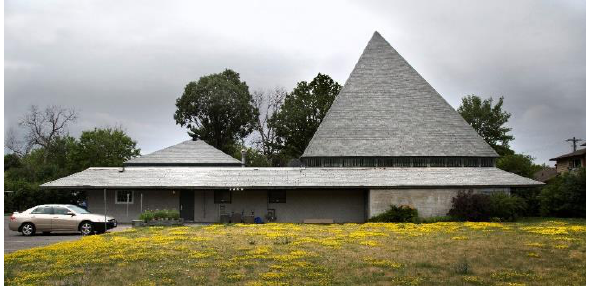
Figure 8. Ottawa East SDA south facade